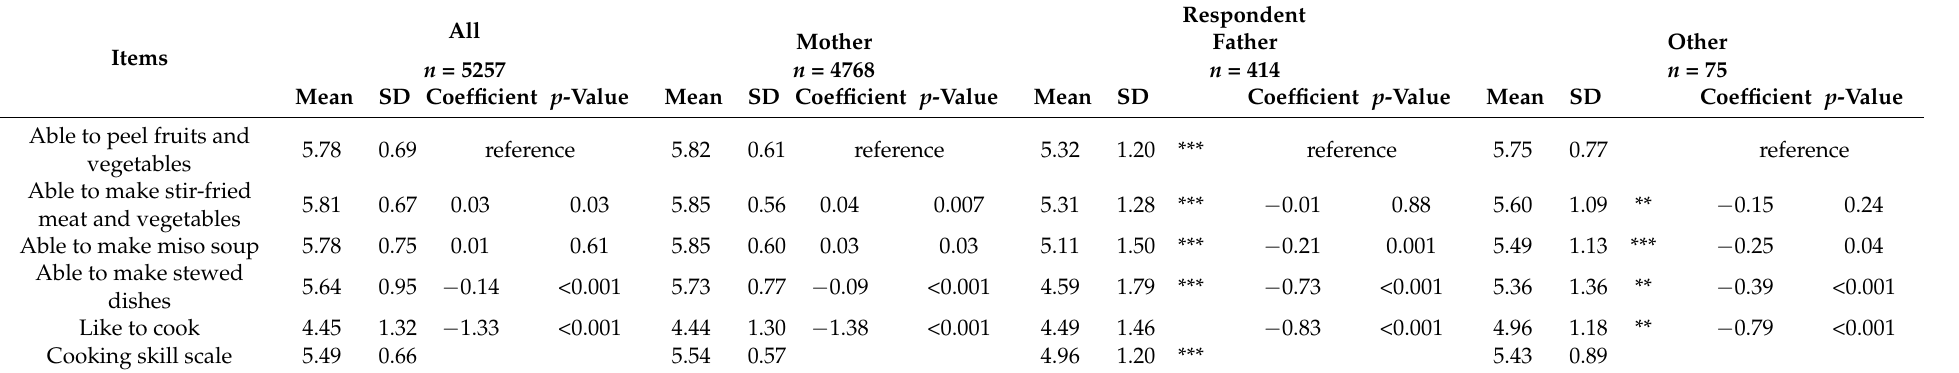
Table 2. Cooking skills scale scores of Japanese caregivers ( n =